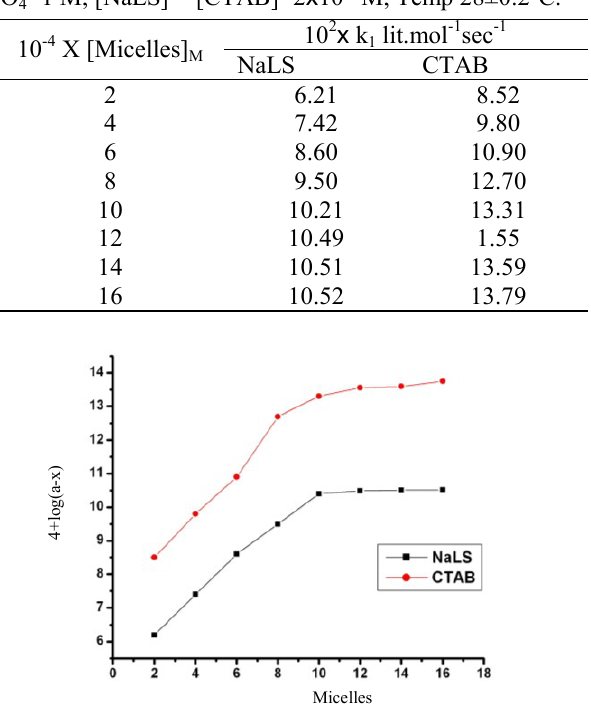
Micelles Figure 1. First order dependence